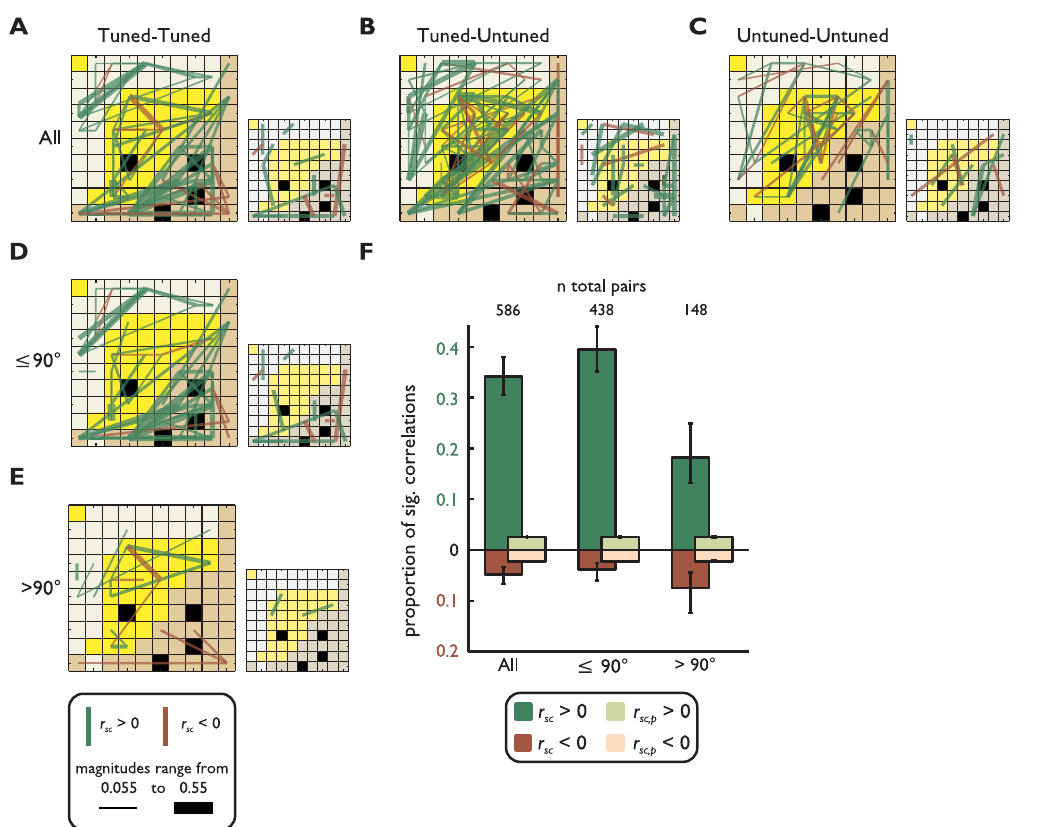
Figure 5. Spike count correlations sorted by neurons’ visuospatial tuning preferences. Like Figure 3 , correlations are visualized on the MEA. Each square represents an electrode, and lines between the electrodes represent correlations between neurons recorded on those electrodes. The thickness of the line is proportional to the magnitude of the correlation (from 0.055 to 0.55) and the color represents the sign (brown=negative, green=positive). The large panels represent r sc and the small panels r sc,p . The row displays data from A ) tuned-tuned, B ) tuned-untuned, and C ) untuned-untuned pairs. The column displays data from A ) all tuned pairs, D ) tuned pairs with RFs separated by less than or 90 u , and E ) RFs separated by more than 90 u (bottom). F ) The bar graph displays the proportion of significant correlations for all the tuned-tuned pairs (see